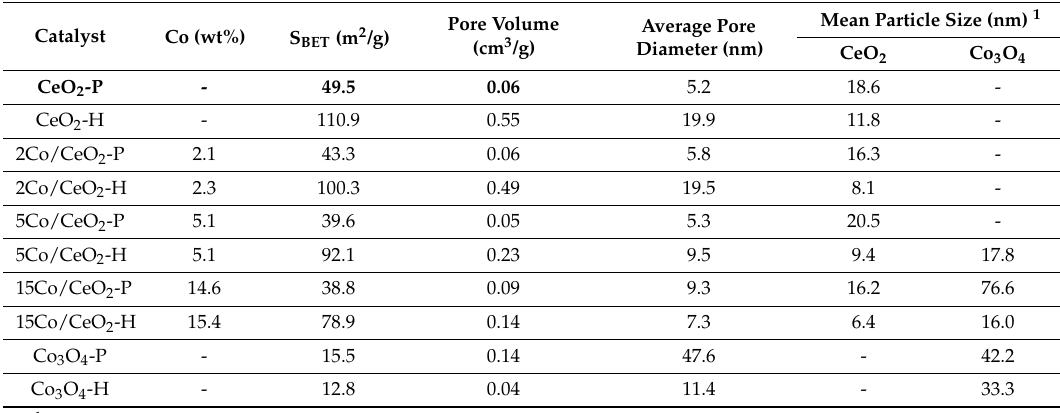
Table 1. Physicochemical properties of catalytic